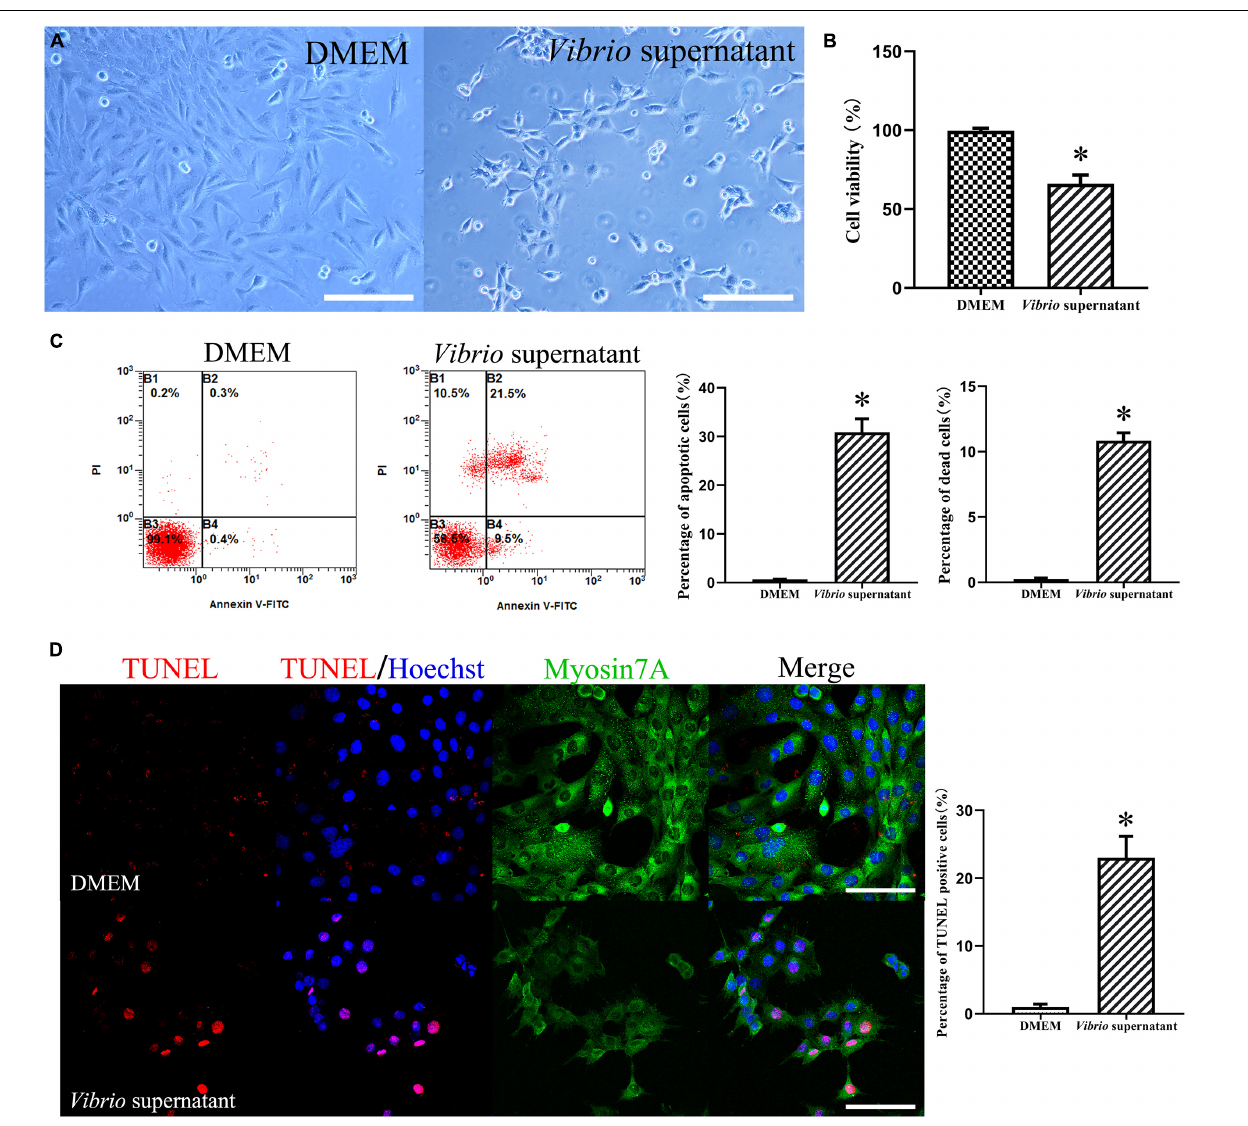
FIGURE 4 | Cytotoxic effects on House Ear Institute-Organ of Corti 1 (HEI-OC1) cells induced by Vibrio alginolyticus . Cytopathic effects of HEI-OC1 cells treated with Vibrio supernatant for 12 h (A) . Quantitative analysis of cell viability measured by cell-counting kit (CCK)-8 assay after exposure to bacterial supernatant (B) . The proportion of apoptotic and dead cells was counted by flow cytometric analysis with Annexin V/propidium iodide (PI) double staining (C) , and the number of TUNEL-positive stained apoptotic cells was calculated (D) . The results are expressed as the mean ± standard deviation (SD) [ ∗ p < 0.05, vs. control/Dulbecco’s modified Eagle’s medium (DMEM)]. Scale bars: A = 200 µ m, D = 100 µ